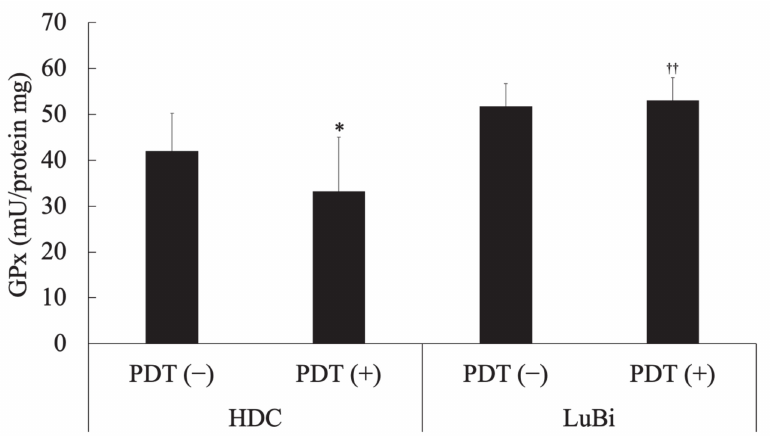
Figure 5. Determination of cellular glutathione peroxidase (GPx) activity. Cellular glutathione perox- idase activity was measured spectrophotometrically using the Fluorimetric Glutathione Peroxidase Assay Kit according to the manufacturer’s protocol. In addition, the protein content of the cell lysate was measured spectrophotometrically using the TaKaRa BCA Protein Assay Kit according to the manufacturer’s protocol. Results are presented as mean ± standard deviation ( n = 6). Groups were compared using Sidak’s multiple comparison test, * p < 0.05 vs. HDC PDT ( − ) and †† p < 0.01 vs. HDC PDT